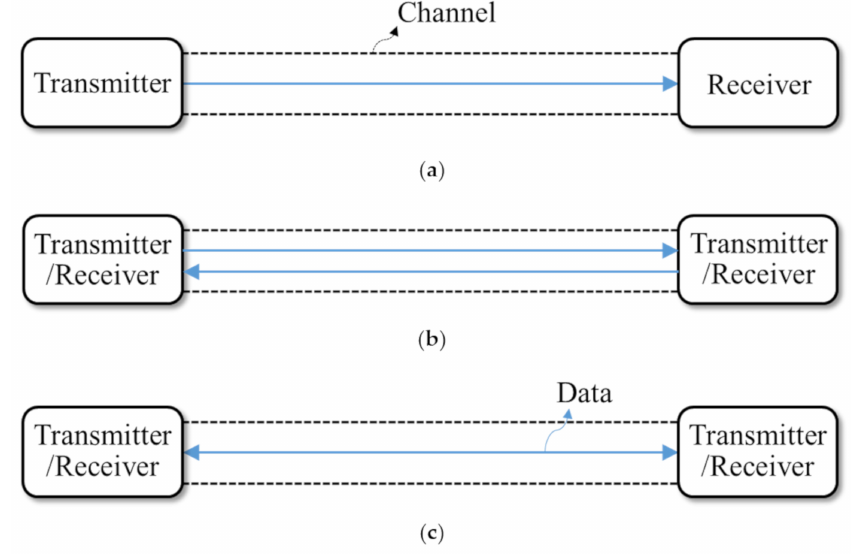
Figure 4. Synchronous interface working modes: ( a ) simplex mode; ( b ) half-duplex mode; and ( c ) full-duplex mode.